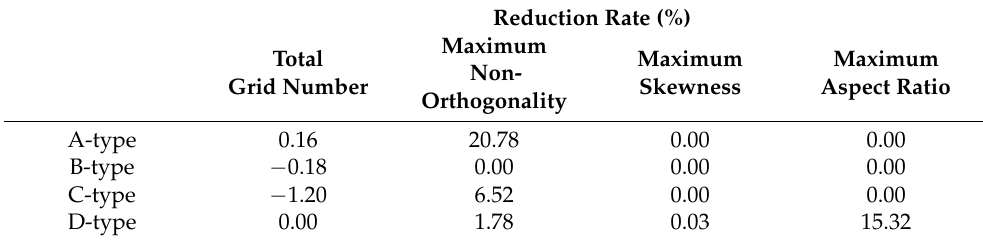
Table 5. Grid model improvement according to optimization.